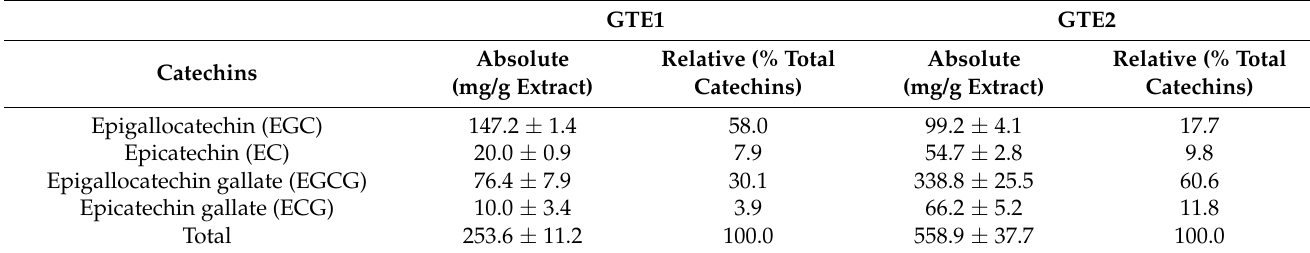
Table 1. Mean content of epistructured catechins in an EGC-rich green tea extract (GTE1) and an EGCG-rich green tea extract (GTE2). GTE1